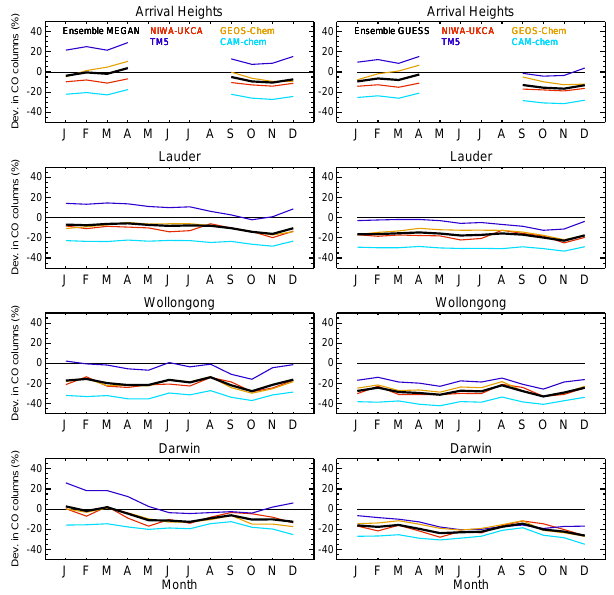
Figure 5. Percentage differences between modelled and observed multi-annual mean CO columns at Arrival Heights, Lauder, Wollon- gong, and Darwin from two simulations with CLM-MEGANv2.1 (left) and LPJ-GUESS emissions (right) respectively.